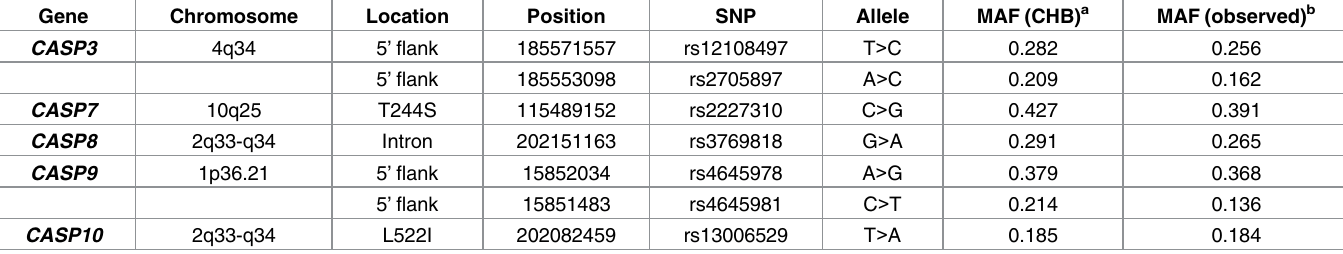
Table 1. SNPs selectedin CASP genes and their allele